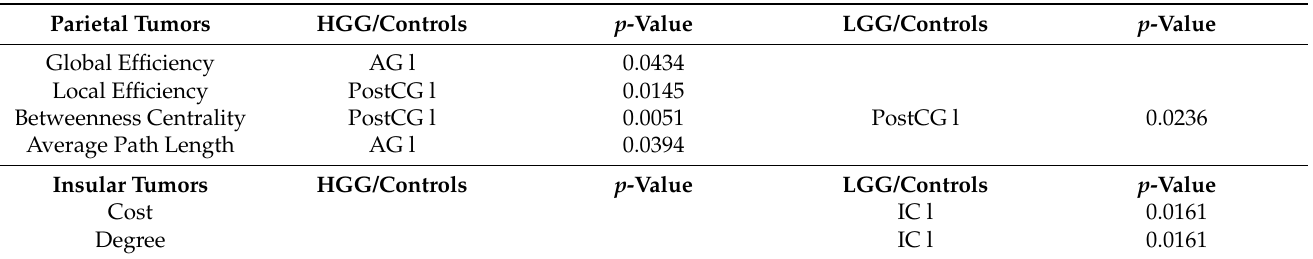
Table 3. Graph-theory statistics results for gliomas involving the parietal lobe and insula. Significance is reported as FDR corrected p -value.